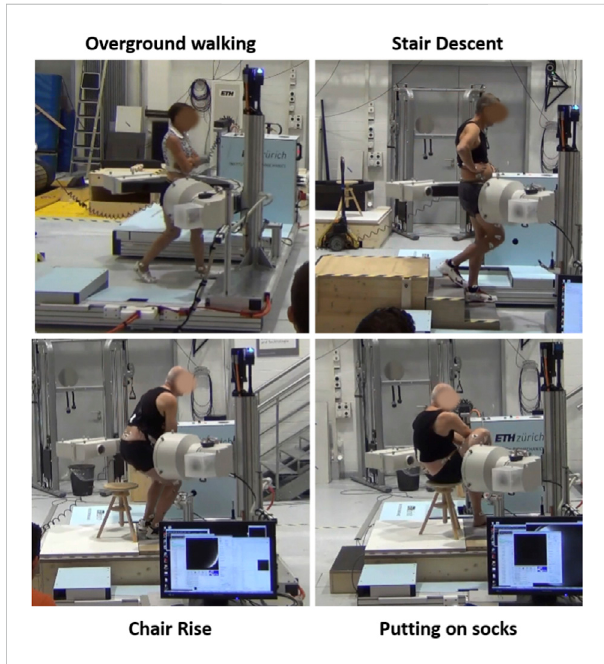
Synchronized moving video- fl uoroscopy and motion capture measurement of activities of daily